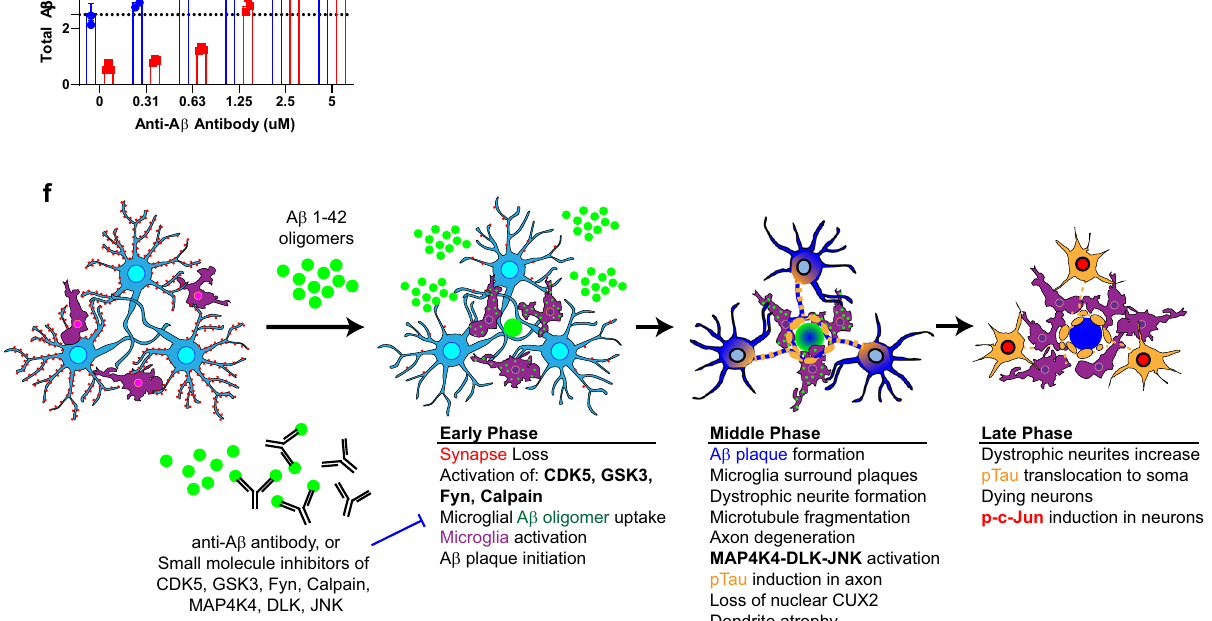
Fig. 8 Anti-A β protects neurons by keeping A β soluble in supernatant and antibody effector function is not required. a , b iPSC neurons and astrocytes treated with 5 μ M sA β 42s followed by serial dilutions of anti-gD and anti-A β antibodies with IgG1 and LALAPG backbones with and without iPSC microglia. Results for dendrite protection (MAP2 area) ( a ) and synapse protection (synapsin count) ( b ) were analyzed via IC50 curve fi tting using Prism software. Microglia provide baseline protection as shown by an upward shift in the anti-gD graph when microglia are added (gD IgG1 alone, blue; gD IgG1 + microglia, dark blue). Anti-A β antibody backbones protect dendrites and synapses similarly without microglia (Anti-A β IgG1, red; Anti-A β LALAPG, green) and with microglia (Anti-A β IgG1, dark red; Anti-A β LALAPG, dark green). c , d Neuron, astrocyte, microglia triculture treated with 5 μ M sA β 42s (solid lines) and pro-in fl ammatory cytokines (dashed lines), then serial dilutions of gD antibody (black lines) and anti-A β antibody (red lines) were added. c Basal dendrite protection (MAP2 area) is lost in a neuroin fl ammatory environment, and anti-A β shows dose-dependent ef fi cacy. d Plaque formation (Methoxy-X04 total intensity) increases in pro-in fl ammatory conditions, however, anti-A β shows similar plaque reduction. e iPSC microglia (red) were treated with 5 sA β 42s and serial dilutions of anti-A β antibody; no cells wells were used as control (blue). The supernatant was collected and anti-A β ELISA was performed to measure total A β concentration. Anti-A β antibody treatment increases soluble A β species present in the culture supernatant. f Summary of sequential events in the iPSC AD model. Data are presented as mean values + / − SEM and n = 4 wells. Two-way ANOVA with Tukey ’ s multiple comparisons